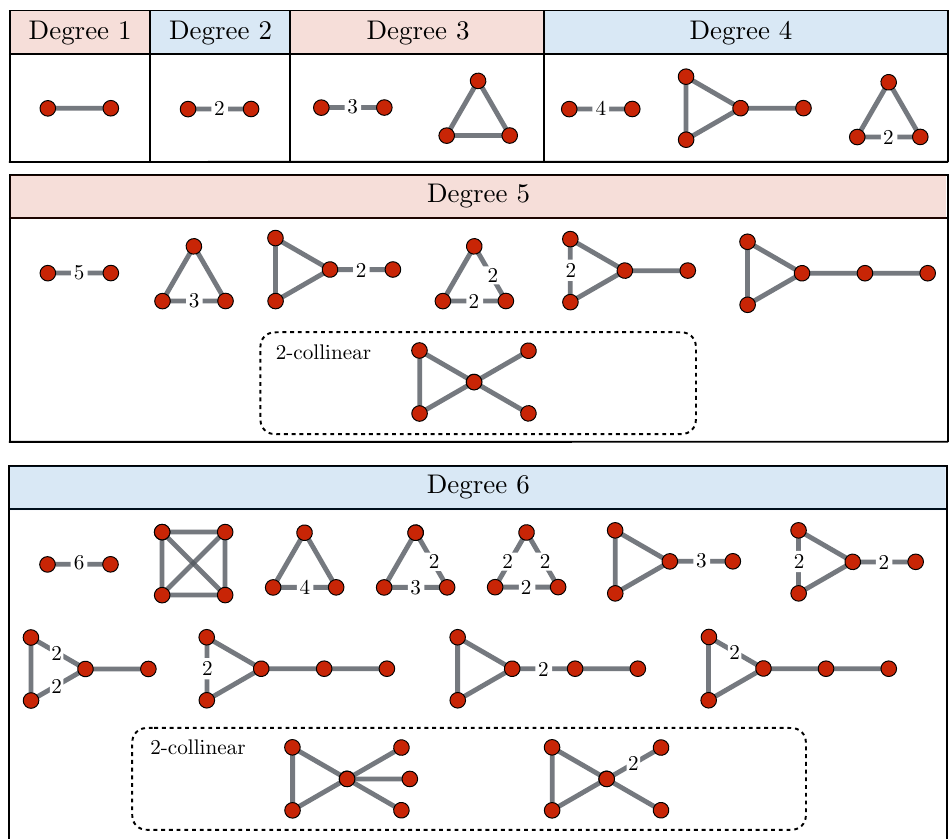
Table 5. Basis of prime EFPs up to degree 6 in the 1-collinear expansion. A generic EFP up to degree 6 can be expressed as a polynomial in terms of these bases elements. To extend this basis to the 2-collinear approximation requires one new basis element at degree 5 and two at degree